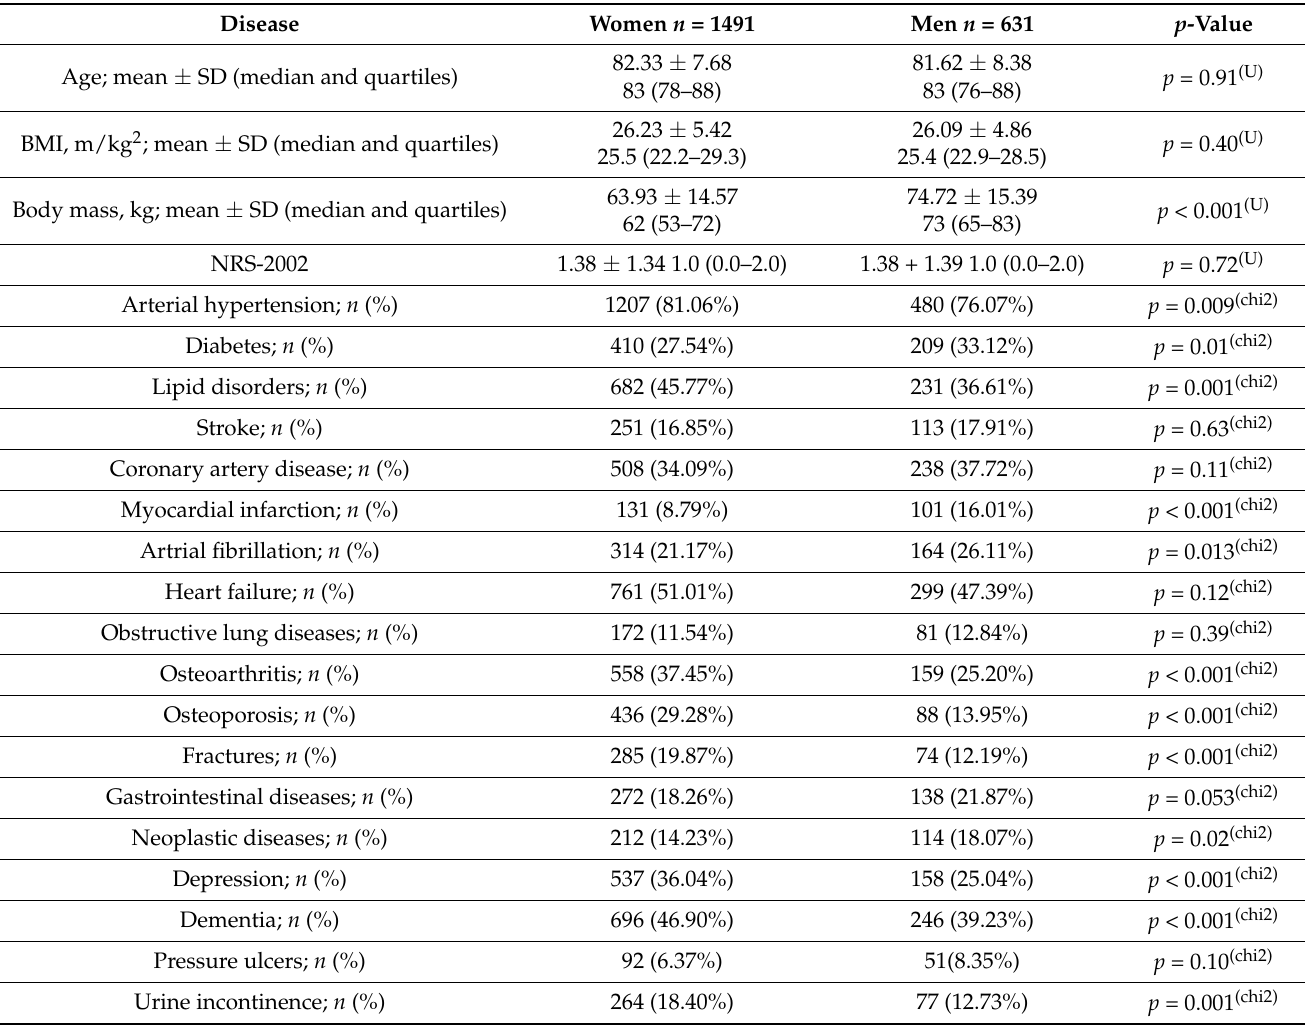
Table 1. Characteristics of the patients according to